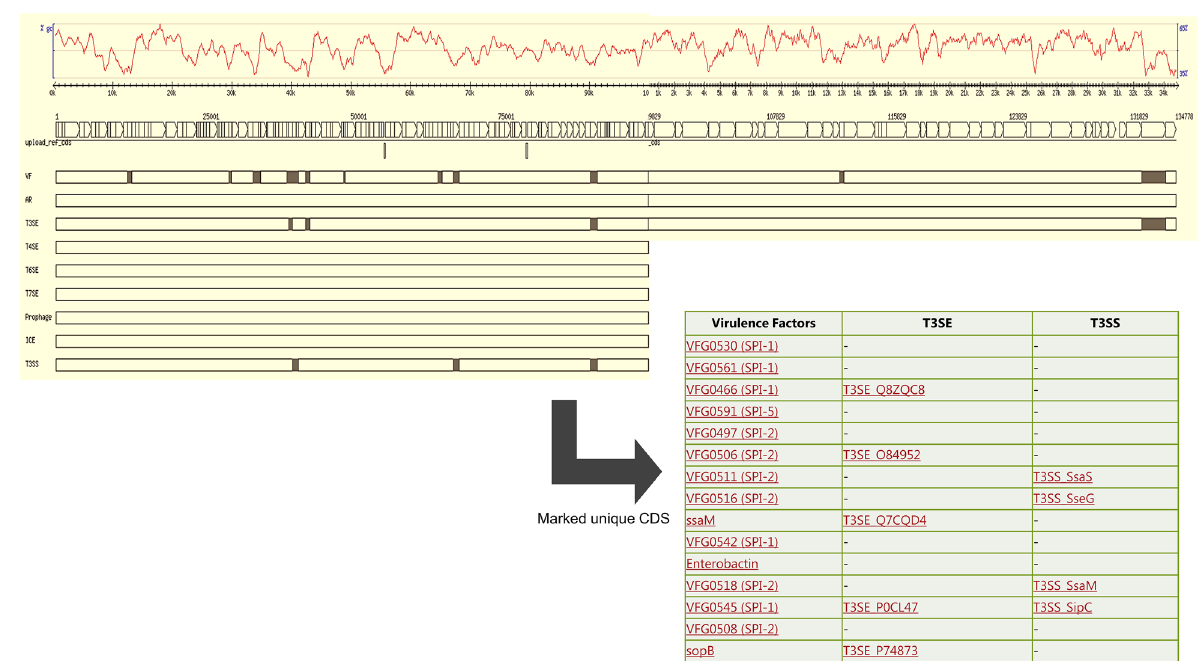
Figure 3. Annotated genes encoded in the unique CDS of the enterica species group (including S. Waycross) in Part A of Fig. 2. The solid marks in the upper image is displayed in the lower table with the actual genes